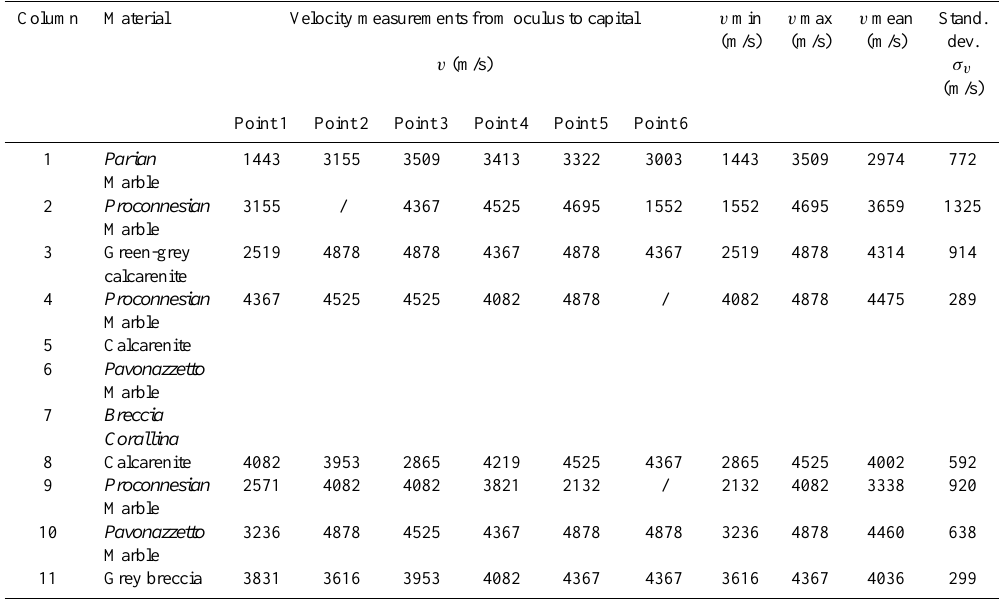
Table 1. Ultrasonic tests on the external columns of the rose window.